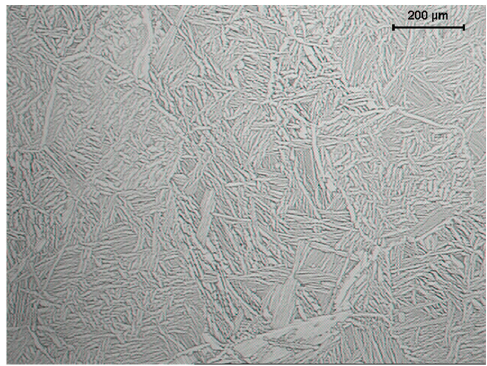
Figure 1. Optical micrograph of Widmanstätten microstructure.